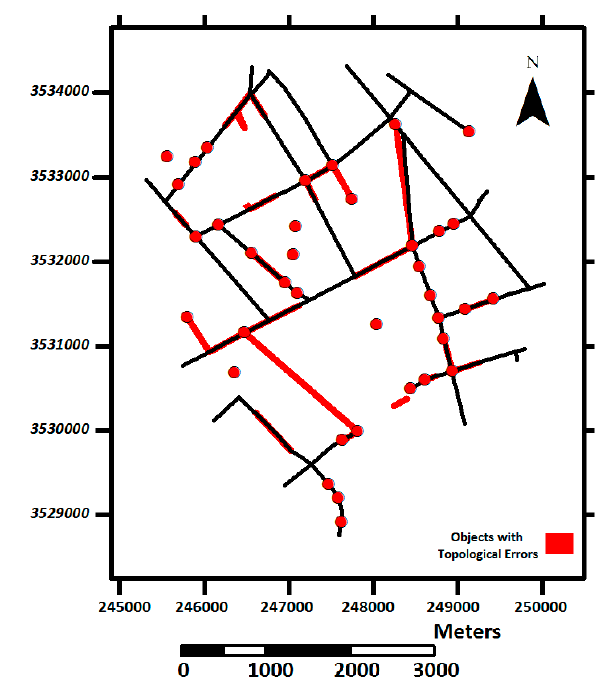
Fig. 16. Topological errors in